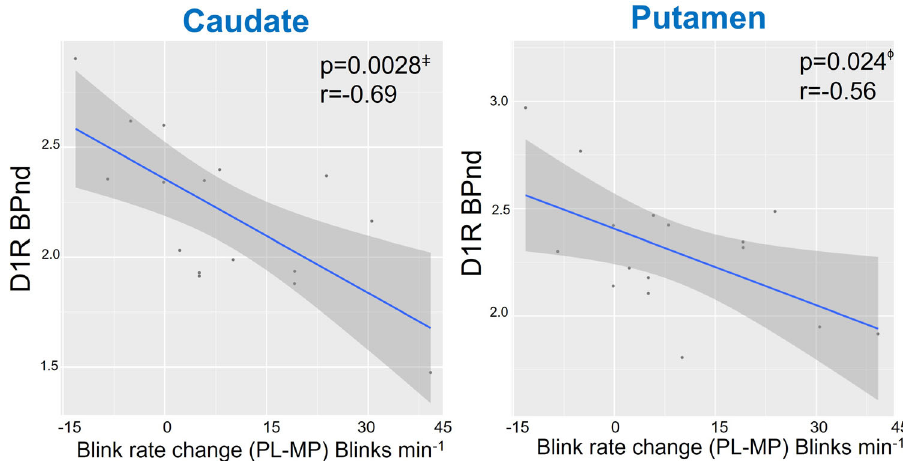
Fig. 4 EBR changes with MP (PL-MP) were negatively correlated with baseline D1R in caudate and putamen. Participants with low D1R reduced EBR with MP whereas those with the higher D1R increased blink rates. ( n = 16). Shaded area indicates 95% Con fi dence Interval (CI). Each points represents a value from each